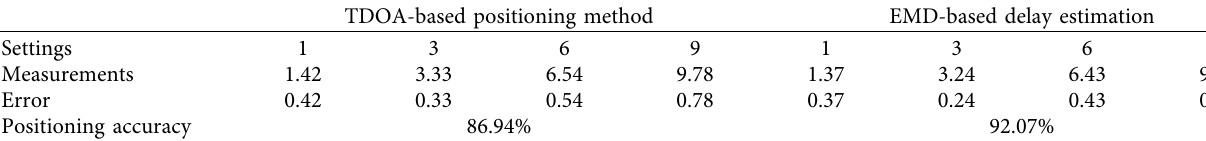
Table 3: Target localization results when the sensor distance is 5m.